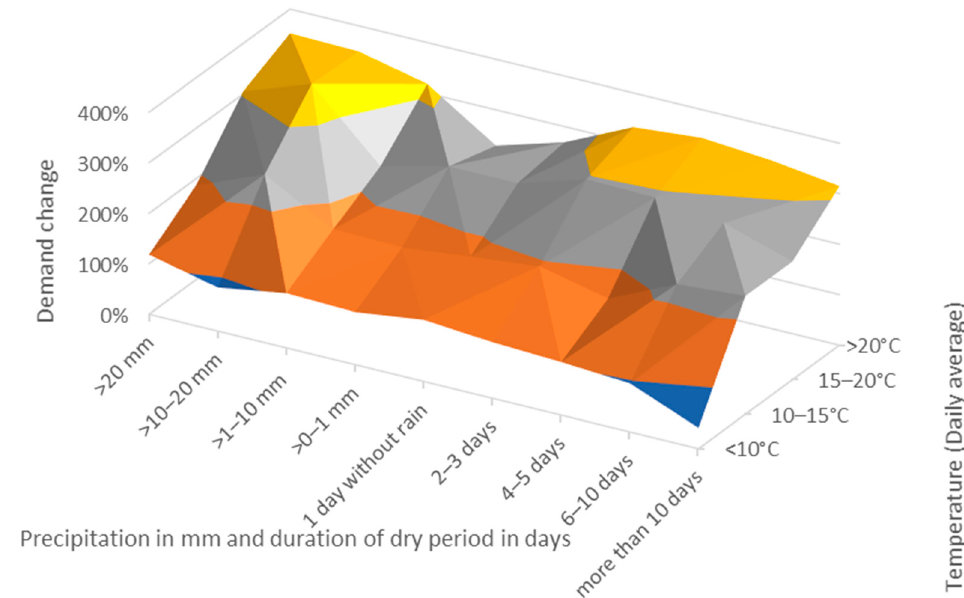
Figure 4. Hotel water demand change (total demand without irrigation) with temperature and precipitation. Source: [6]